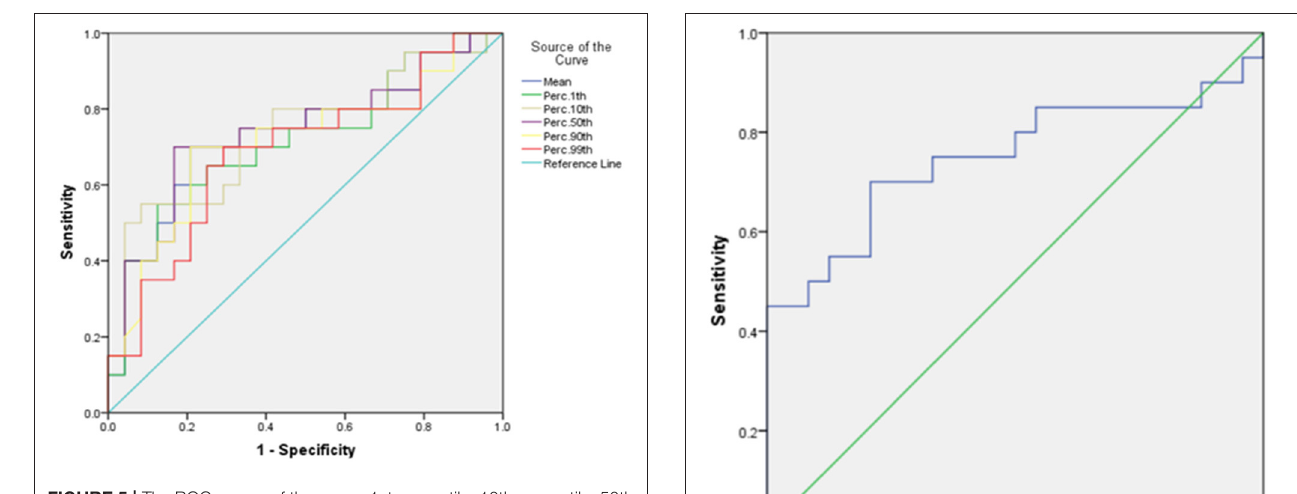
FIGURE 5 | The ROC curves of the mean, 1st percentile, 10th percentile, 50th percentile, 90th percentile, and 99th percentile in T2WI histogram between the endometrial mesenchymal sarcoma group and degenerative hysteromyoma group.